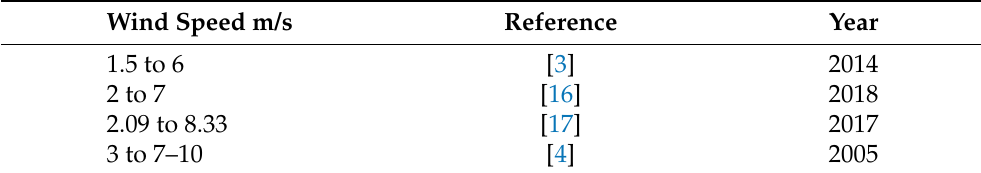
Table 1. Range of wind speeds for oil slick detection according to the